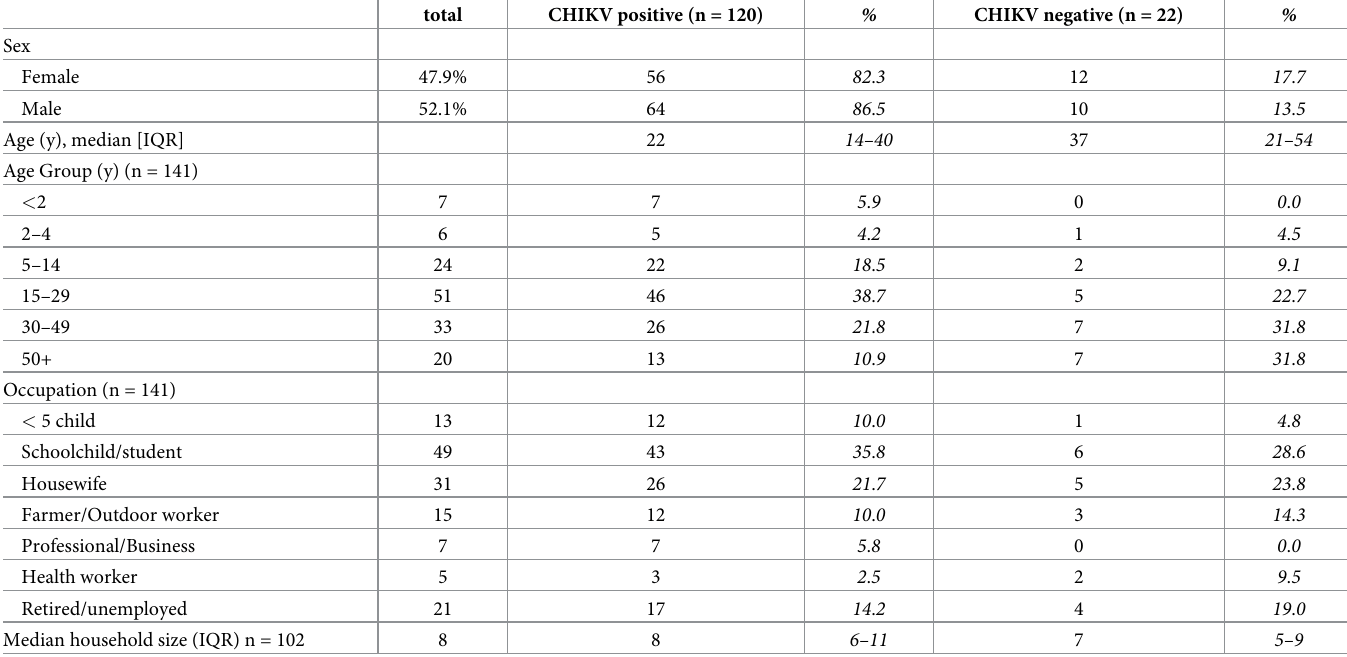
Table 1. Participant characteristics by Chikungunya (CHIKV) RT-PCR